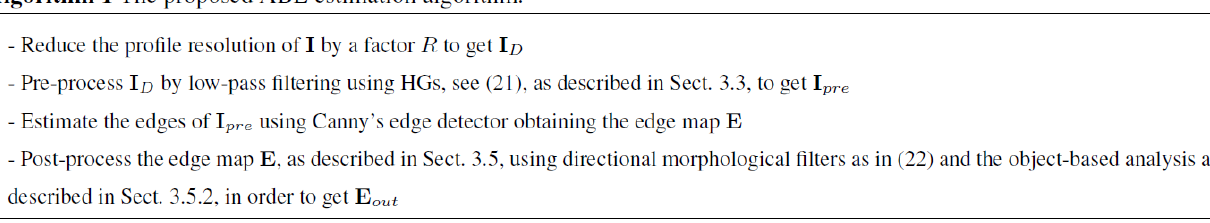
The lidar instrument is equipped with three elastic channels at 355, 532 and 1064 nm and two anelastic N2 Raman chan- nels at 387 and 607 nm (Madonna et al., 2011). Two inde- pendent polarization components of the elastic channel at 532 nm are separately detected in order to measure the par- ticle depolarization ratio (Freudenthaler, 2016). All channels have a raw vertical resolution of 3.75 m, and, except for the 1064 nm where only analog detection is used, all the chan- nels are acquired both in analog and photon-counting mode to enhance the detectable dynamic range. The typical